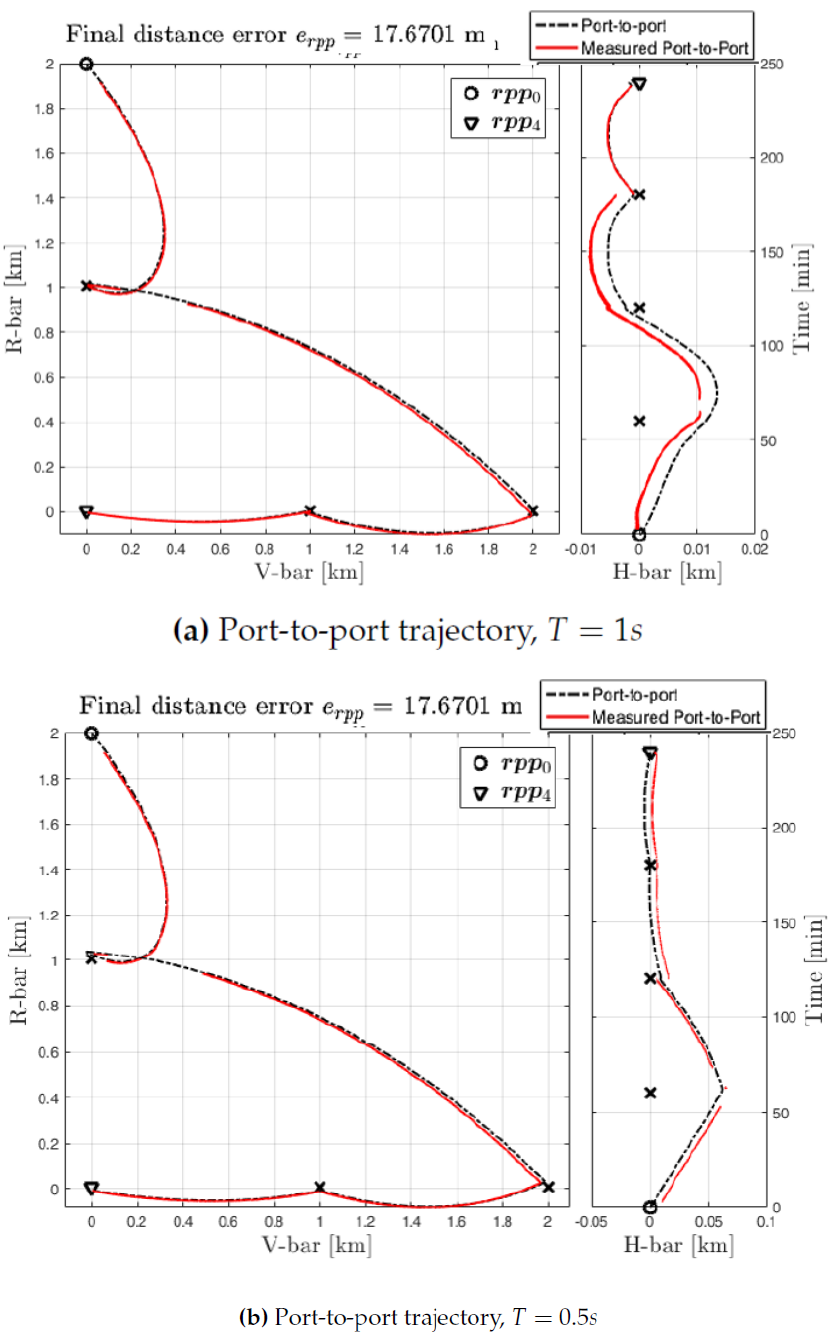
Figure 23. Trajectories varying the PWM frequency (Look-Up table). Using the Heracles mission data, a comparison in terms of thrust consumption is shown in Table 5. The table displays the integral of the acceleration at the thruster during the entire maneuver duration. The “ideal” implies a simulation performed using perfect sensors and actuators, while “non-ideal” indicates results obtained with more accurate models for sensors and actuators as described